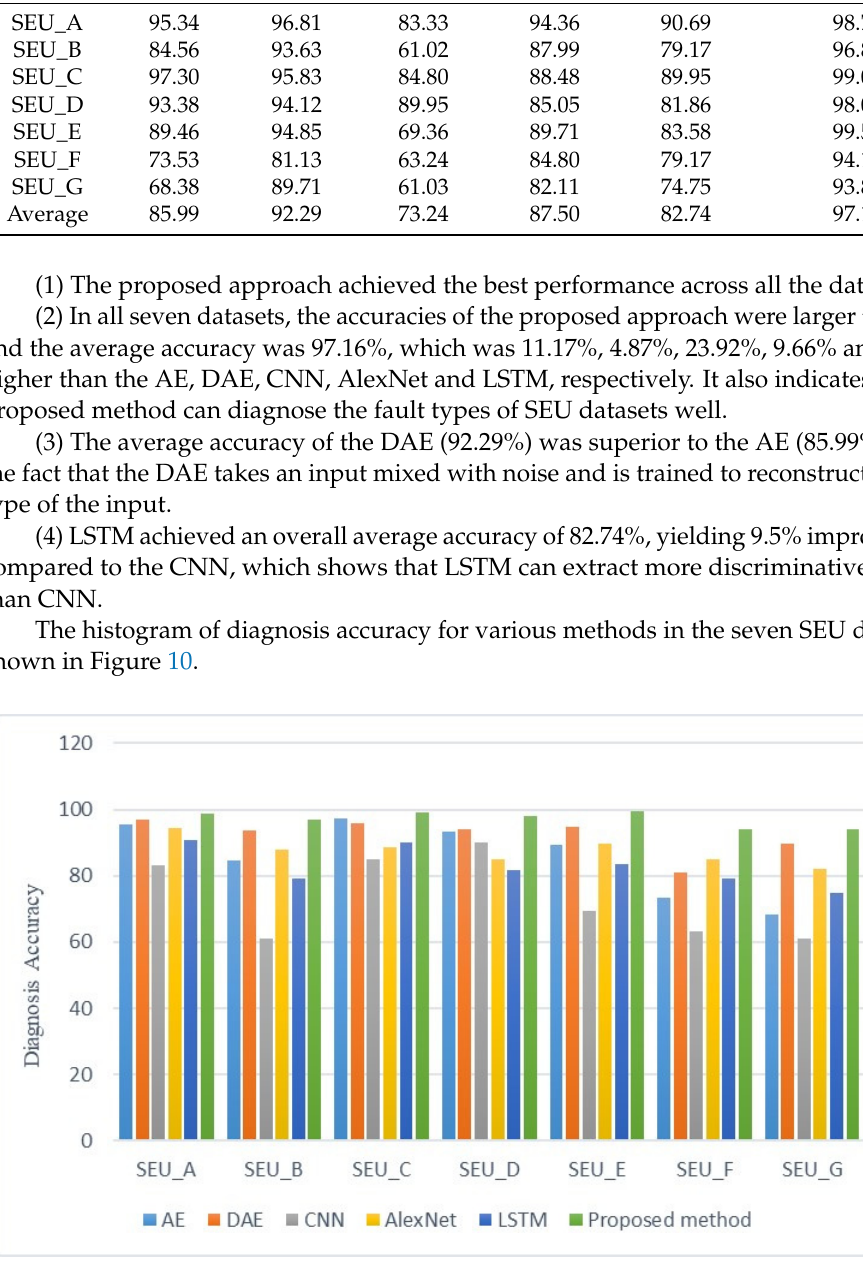
Figure 10. Histogram of diagnosis accuracies for different algorithms.